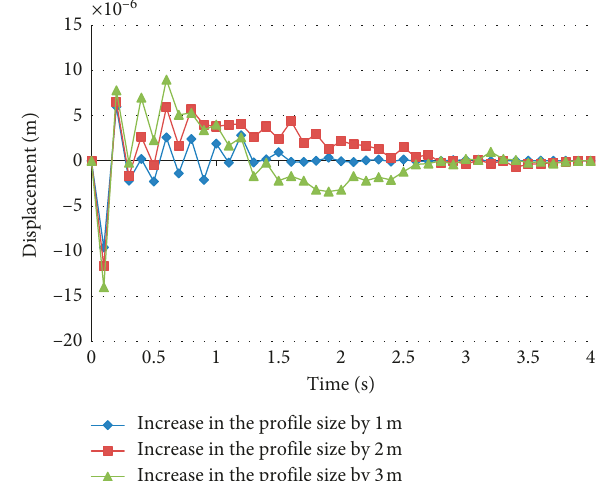
Figure 8: Influence of concrete foundation size on system